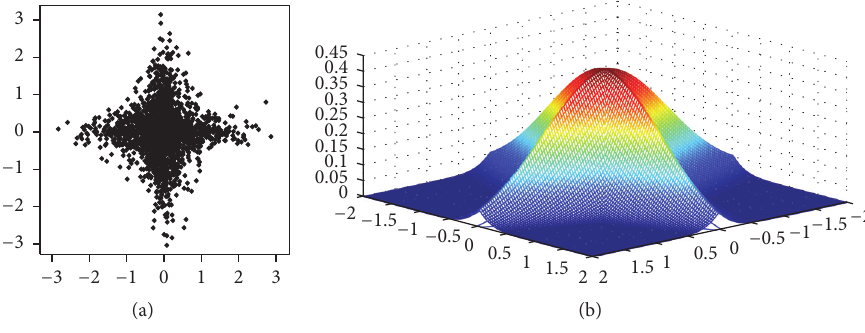
Figure 4: 2000 points (a) simulated according to 𝜑 𝑔